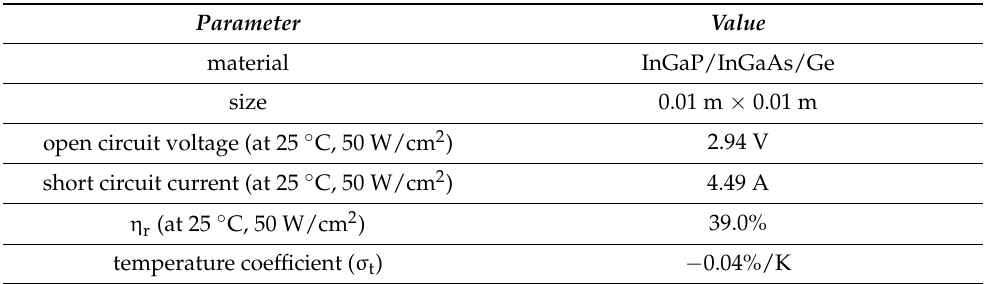
Table 1. Parameters of the Triple-Junction cell.